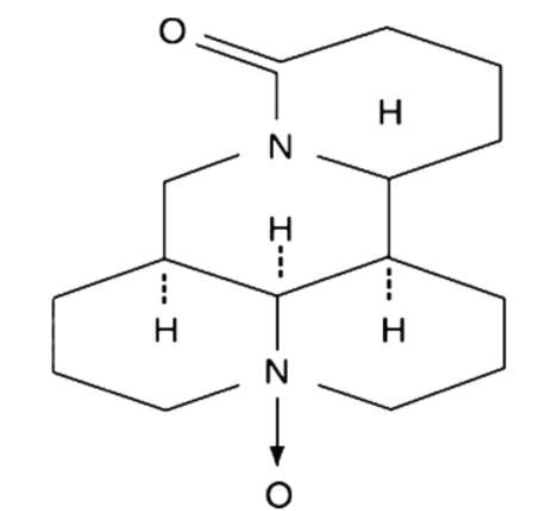
FIGURE 1 - The chemical structure of